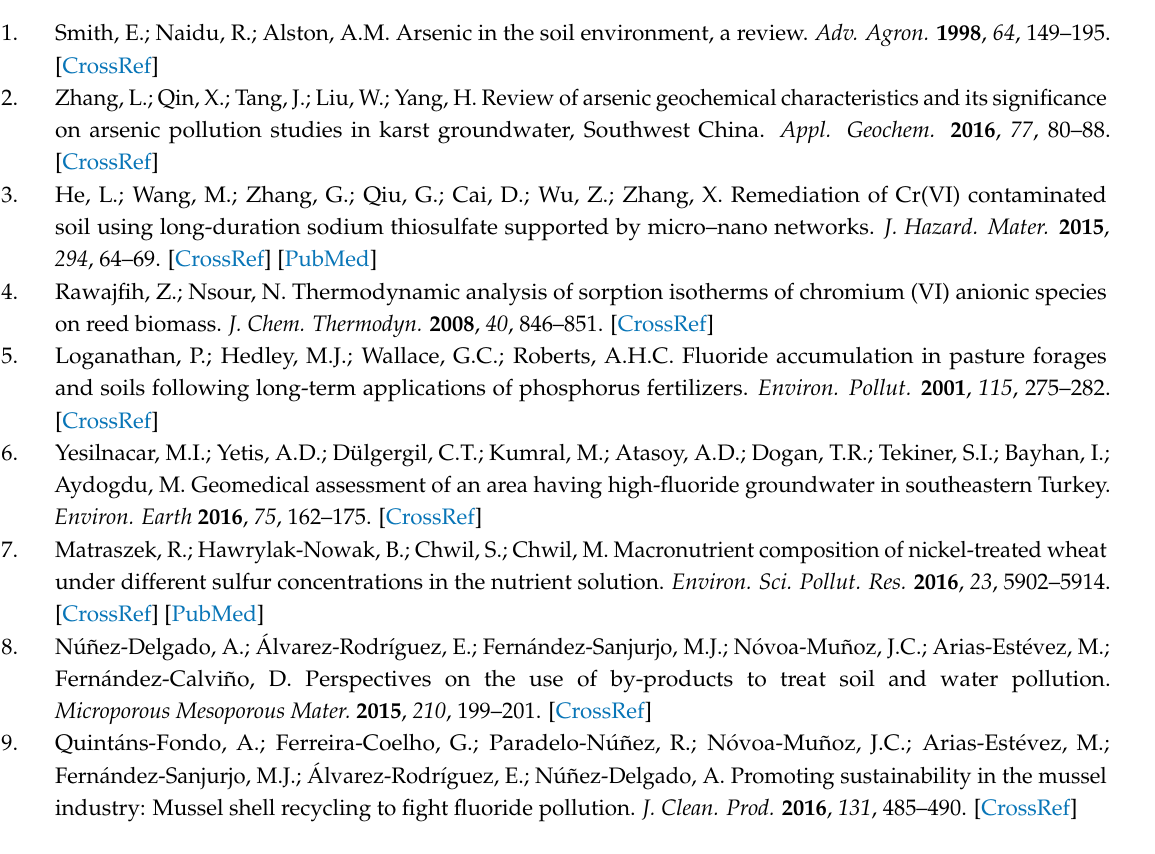
Table S1: Results of the chemical characterization of the wheat straw used. Average values for 3 replicates, with coefficients of variation always <5%); Figure S1: Infrared spectrum of wheat